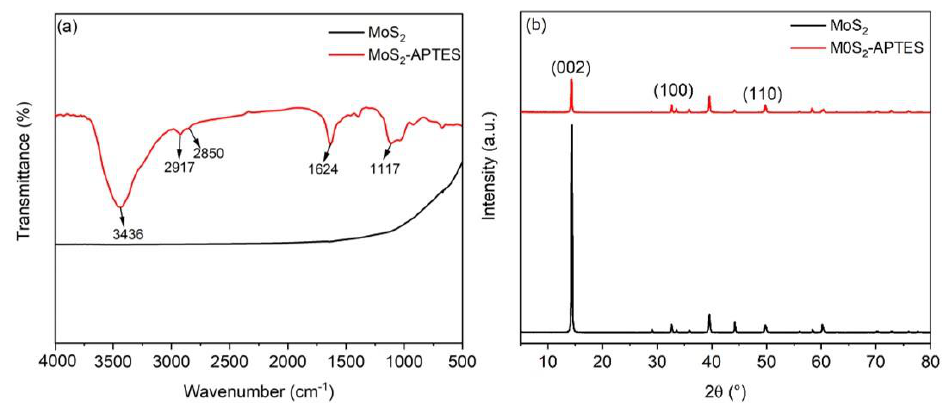
Figure 2. ( a ) FT-IR spectra and ( b ) XRD patterns of MoS 2 , and MoS 2 -APTES.